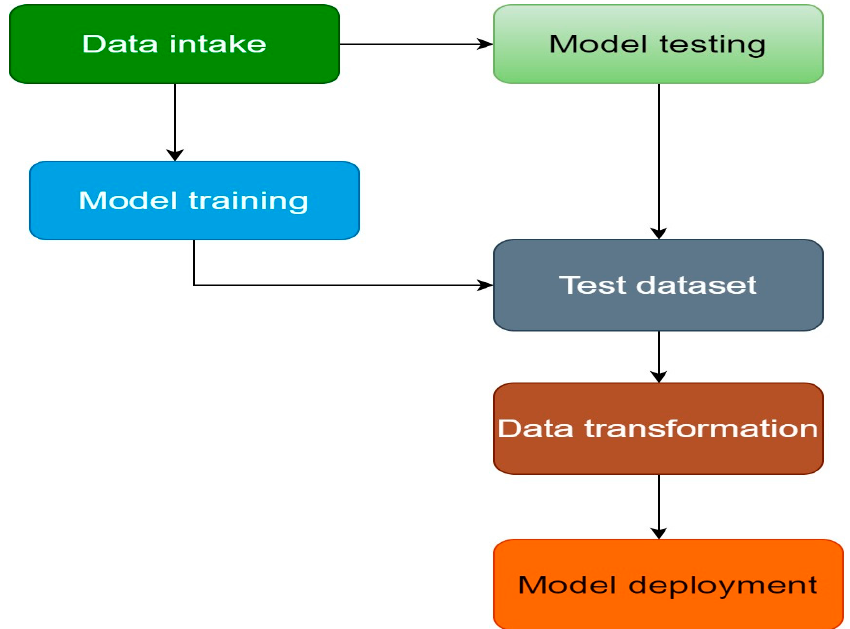
Figure 5. Research framework.